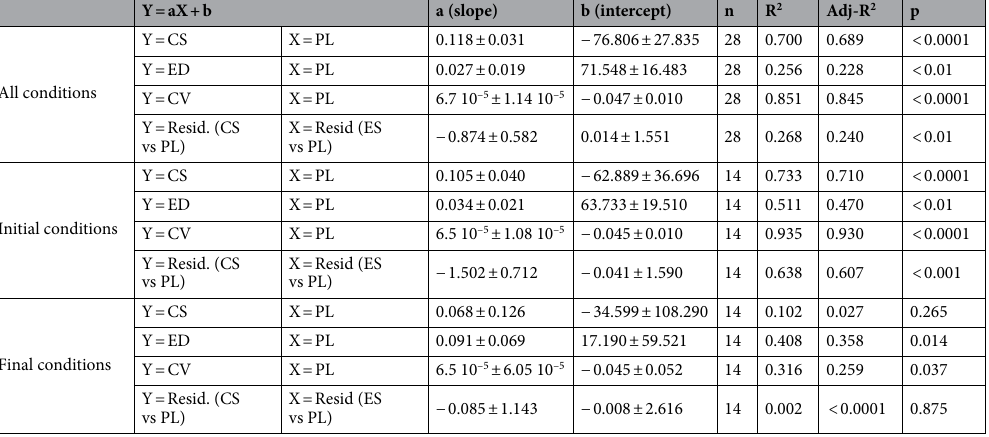
Table 1. Results of the linear regression analysis (Y = aX + b) between reproductive traits of E. affinis as dependent variables (CS, ED and CV) and PL (independent variable) as well as the relationship between the residuals from these regressions (CS vs PL) and (ES vs PL). CS Clutch size, ED Egg diameter, CV Clutch volume, PL Prosome length, ES Egg size, Resid